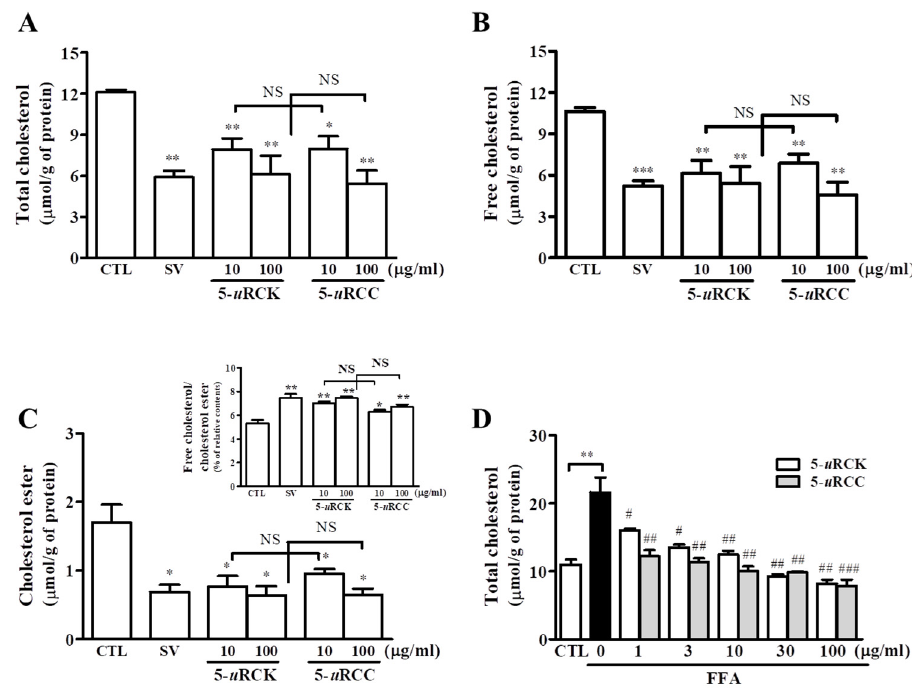
Figure 1. E ff ects of 5- u RCK and 5- u RCC on hepatic cholesterol accumulation. HepG2 cells were treated with 5- u RCK, 5- u RCC, or simvastatin (SV) for 24 h. The cellular total cholesterol ( A ), free cholesterol ( B ), and cholesterol ester ( C ) levels and free cholesterol-to-cholesterol ester ratio (C insert) under normal culture conditions were quantified. ( D ) HepG2 cells were treated with a 1 mM FFA mixture (oleic acid / palmitic acid, 2:1) and various concentrations of 5- u RCK or 5- u RCC (0–100 µ g / mL) for 24 h. * p < 0.05, ** p < 0.01, *** p < 0.001 versus control (CTL). # p < 0.05, ## p < 0.01, ### p < 0.001 versus FFA-treated cells. NS: not significant. The data are represented as the means ± SEMs.